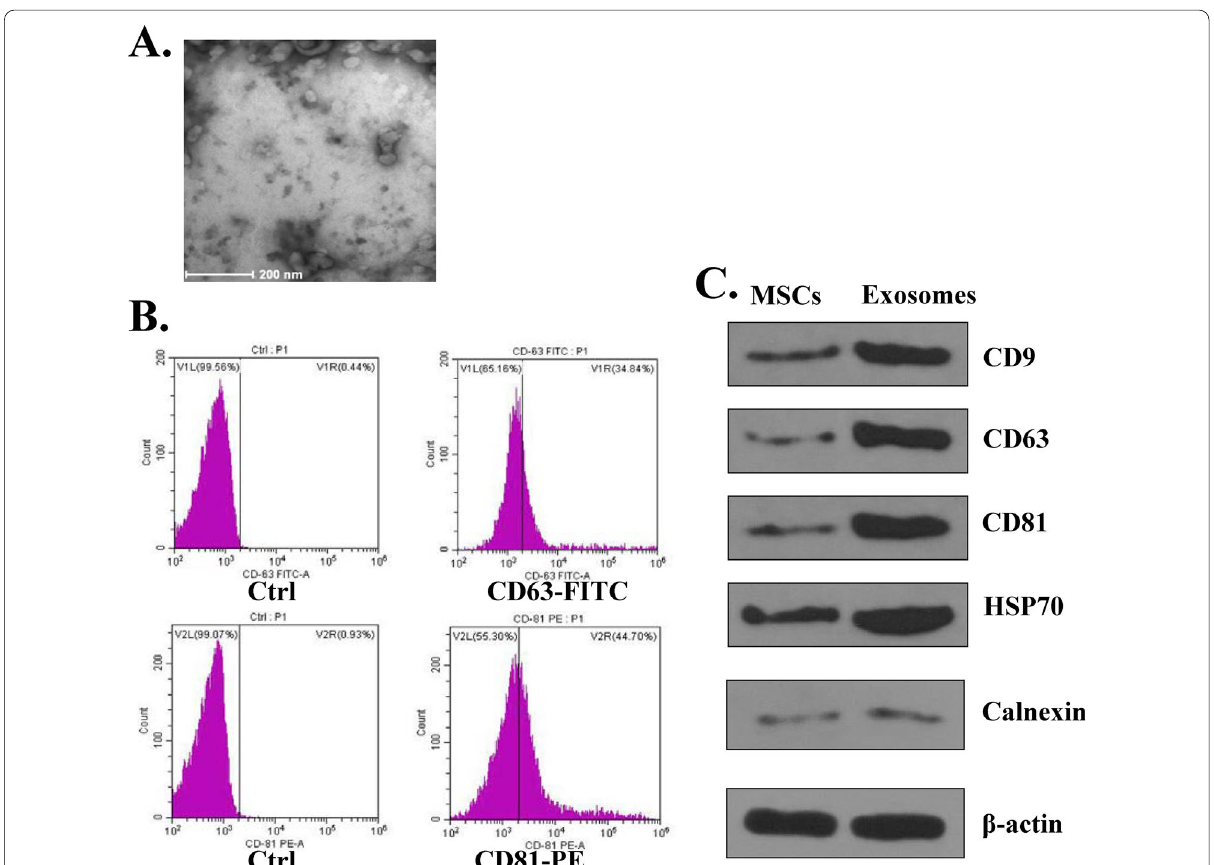
Fig. 1 Characterization of MSCs-derived exosomes. A Morphological change of MSCs-derived exosomes by TEM. B FACS analysis of exosome surface markers CD63 and CD81 in MSCs-derived exosomes. C The protein expression of exosome surface markers (CD9, CD63, CD81, HSP70, Calnexin) in MSCs and MSCs-derived exosomes was evaluated by western